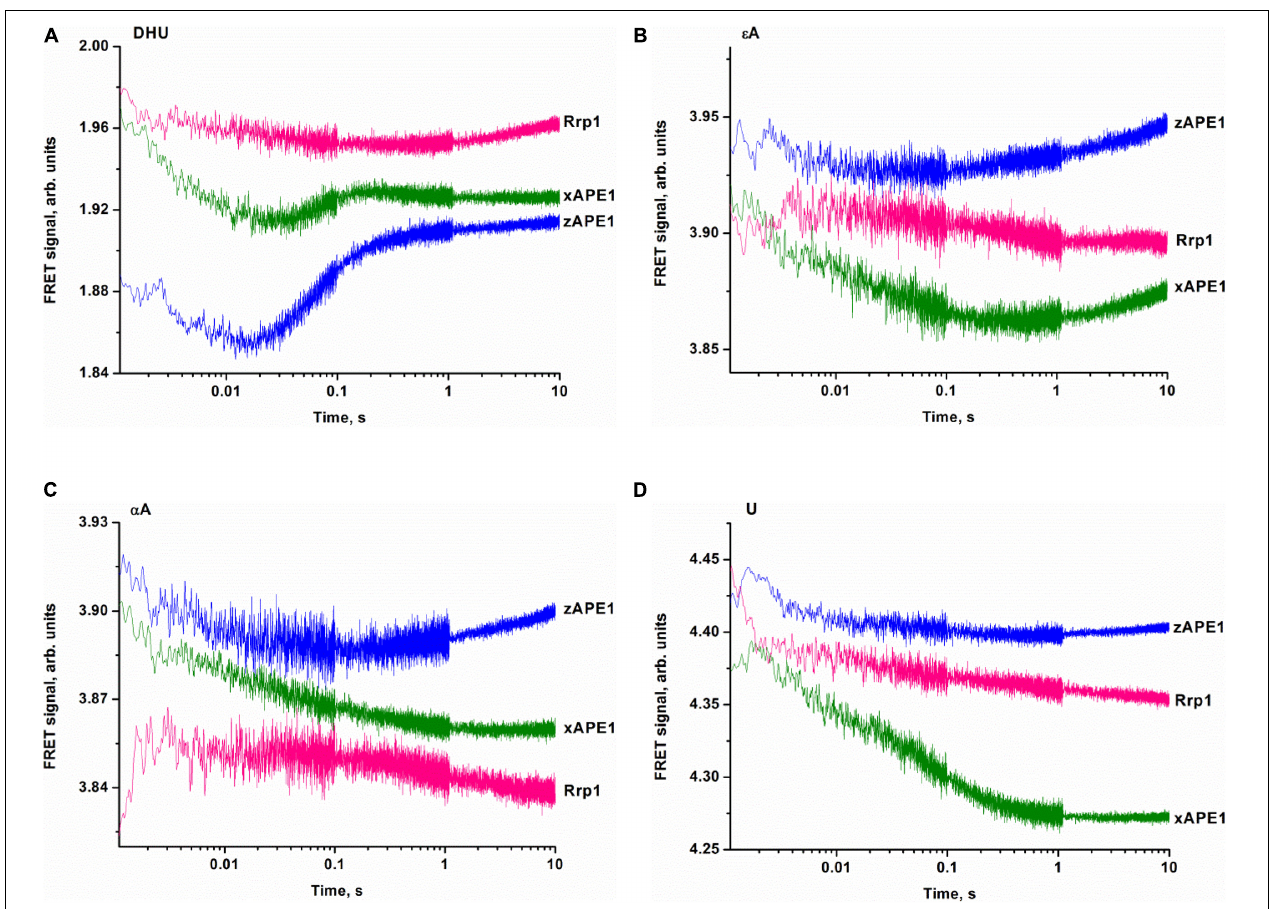
FIGURE 7 | Binding of APE1-like enzymes with the FRET–DHU-substrate (A) , FRET– ε A-substrate (B) , FRET– α A-substrate (C) , or FRET–U-substrate (D) . (Enzyme) = (DNA substrate) = 1.0 µ